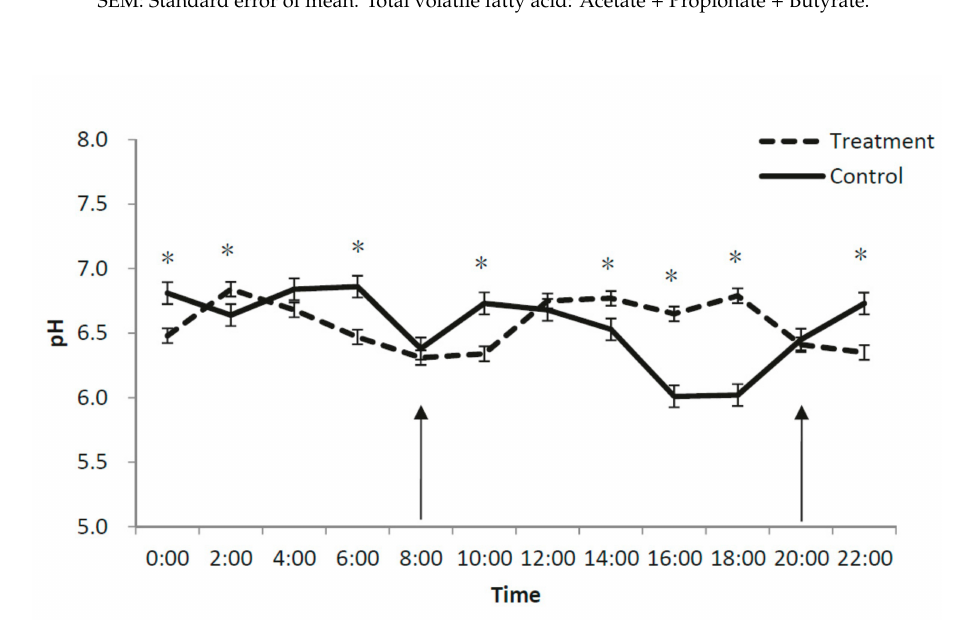
Figure 1. Diurnal e ff ects of a 4.5% licorice root extract supplementation on rumen pH of Karakul sheep